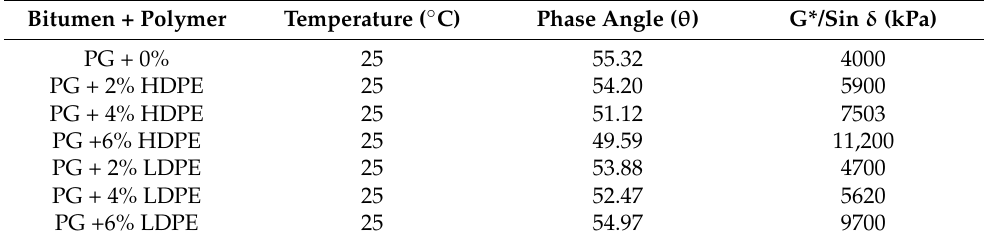
Table 4. RTFO of HDPE and LDPE modified bitumen (PG 58-22).